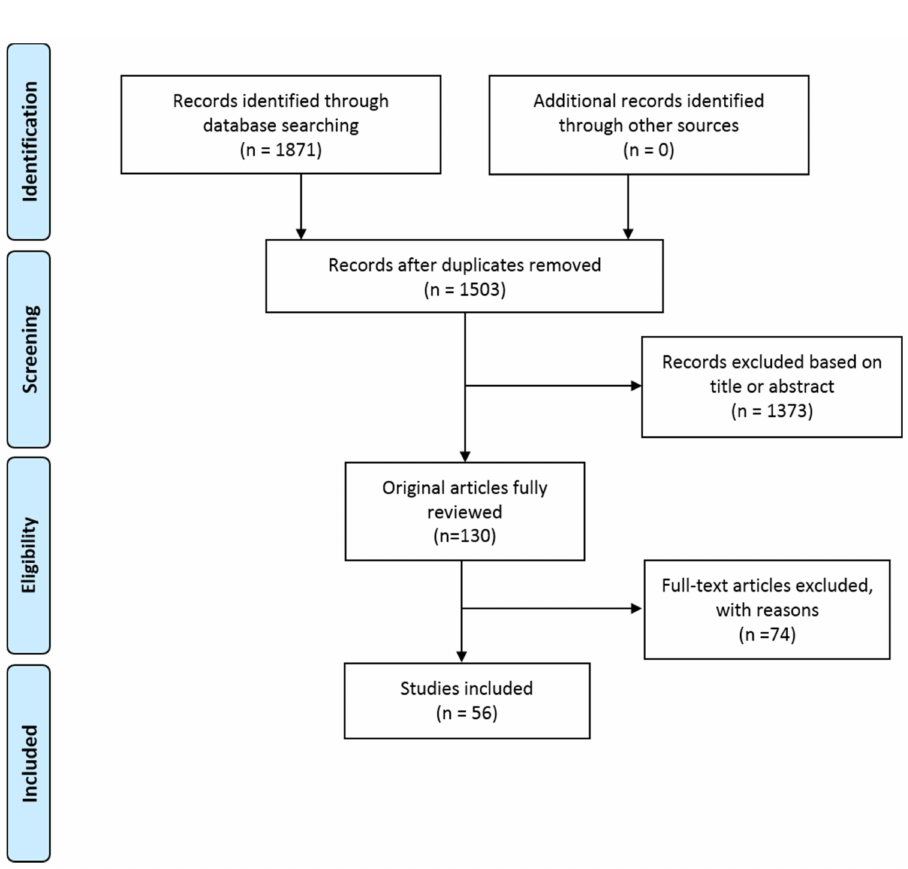
Figure 1. PRISMA flow